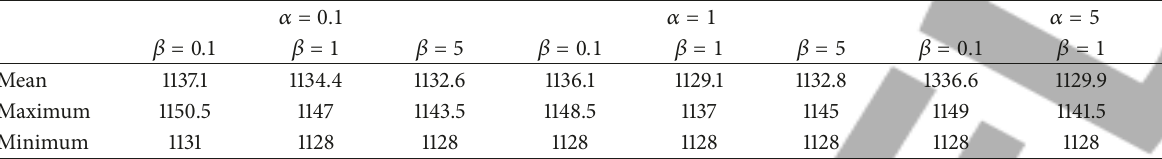
Table 8: One of the best process plans for Part 1.